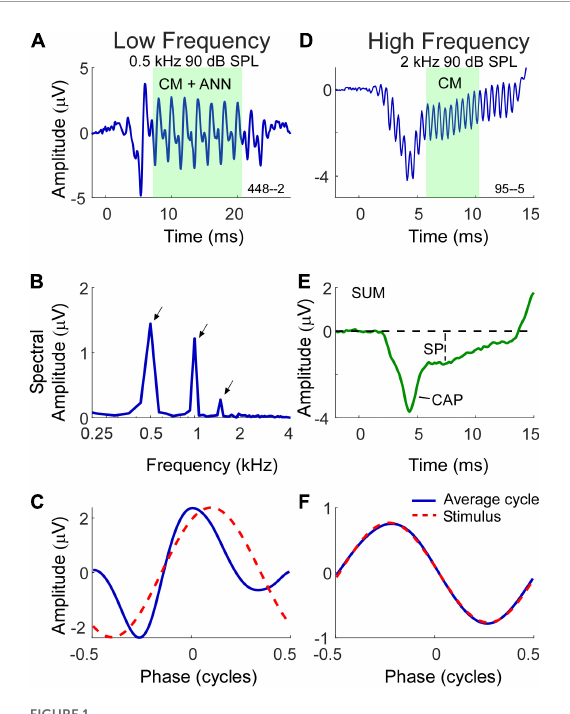
FIGURE1 Morphology of electrocochleography (ECochG) signal waveforms in response to low and high frequency stimuli. (A) Waveform of the ECochG response to a 500 Hz stimulus at 90 dB SPL. The ongoing portion used for analysis is highlighted, and at this frequency consists of both the cochlear microphonic (CM) and auditory nerve neurophonic (ANN) (when present). (B) The fast fourier transform of the ongoing portion of the waveform in panel (A) with first three harmonic peaks (500 Hz, 1 kHz, 1.5 kHz) of statistical significance indicated by arrows. (C) The shape of the response in the form of an average cycle (blue line), which is the average of all cycles in the ongoing portion of the ECochG response. The red dashed waveform represents the sinusoidal morphology of the stimulus shifted to the same phase as the response, as determined from a cross correlation of the two. (D) Waveform of the ECochG response to a 2 kHz stimulus at 90 dB SPL. At this frequency, the ongoing portion of response is composed of the CM only. (E) The SUM response is the average response to the two phases of stimulation. It reduces the CM and highlights the compound action potential (CAP) and summating potential (SP). (F) Unlike the average cycle to low frequencies which contains an ANN, the average cycle to high frequencies is relatively